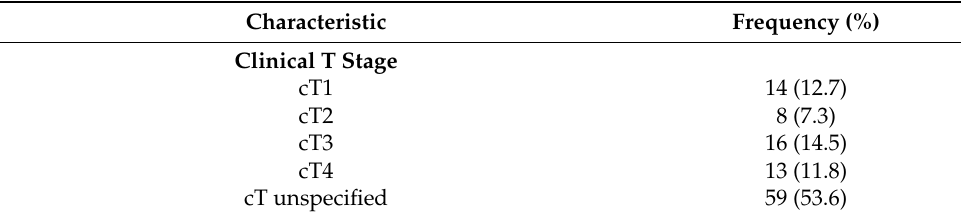
Table 2. Clinicopathologic and treatment